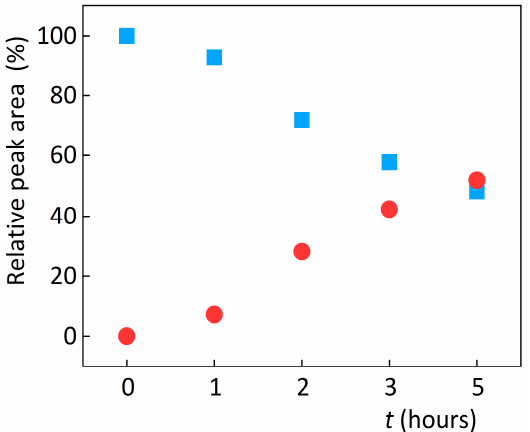
Figure 2. Effect of degradation time on relative peak area of abacavir (squares) and its degradation product OP1 (circles) during chemical oxidation using hydrogen